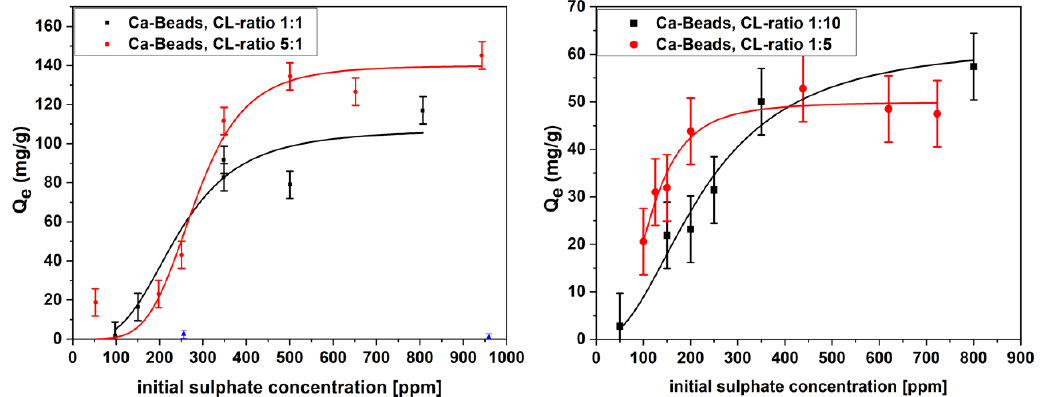
Figure 5. Sulfate adsorption isotherms with cross-linked and calcium imbibed beads (CL-ratio of 1:1 and 5:1 on the left, CL-ratio of 1:5 and 1:10 on the right (for beads with CL-ratio 1:15, see Figure S6 in the supplementary materials) at pH 5 and 295 K. The solid lines are the best-fit according to the Sips isotherm model (cf. Equation (2)).